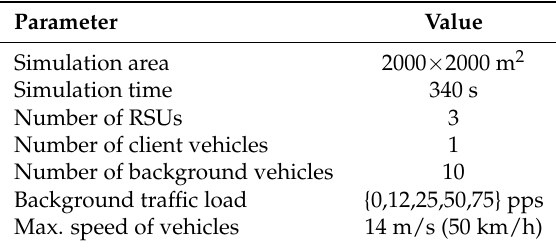
Figure 2. ( a ) Scenario. ( b ) Distance from client to RSUs. ( c ) Number of client neighbors. Table 1. Simulation parameters.